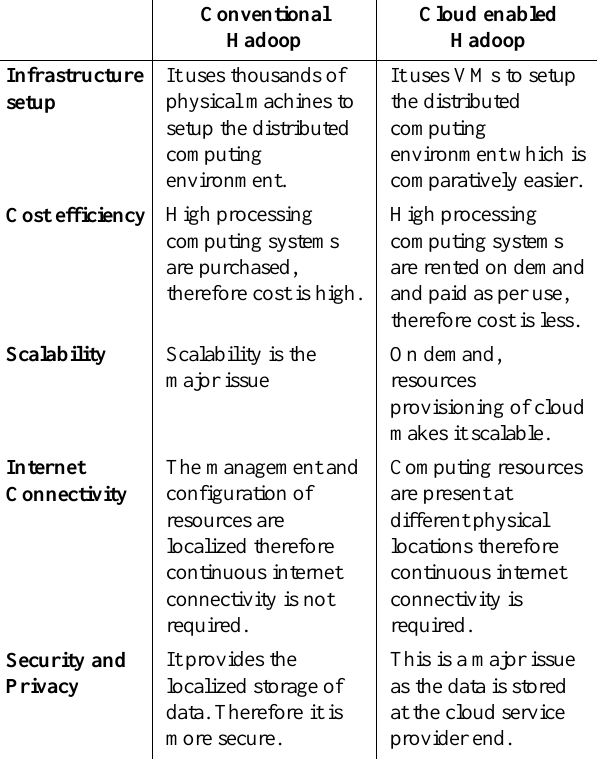
Table 2. Comparison table of conventional hadoop framework with the prosed